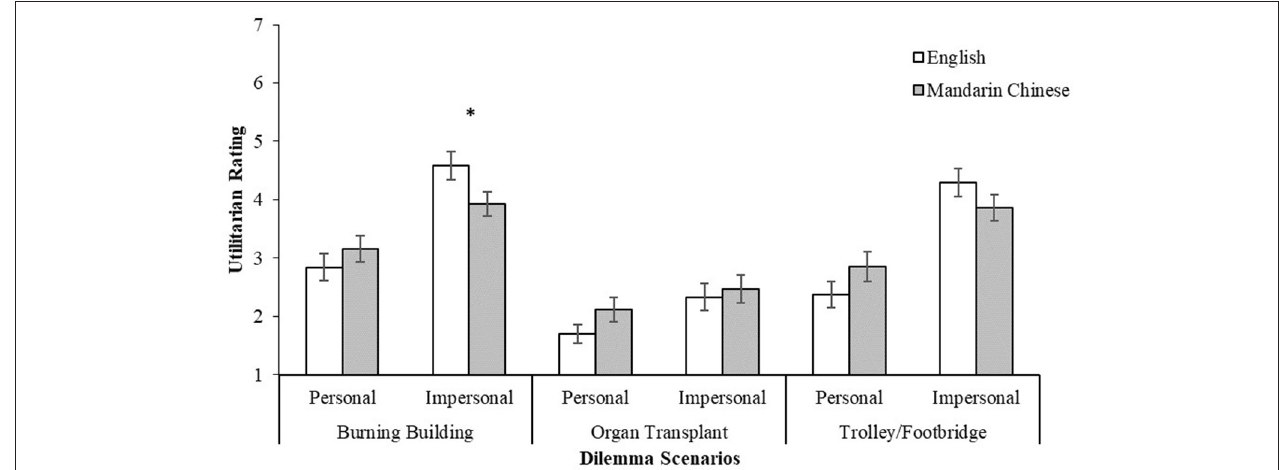
FIGURE 3 | Utilitarian ratings (1 = definitely no, 7 = definitely yes) of the Burning Building, Organ Transplant and Trolley/Footbridge scenarios by personal force (personal/impersonal) and language (English/Mandarin Chinese). Error bars represent standard errors of the means. * p < 0.05.